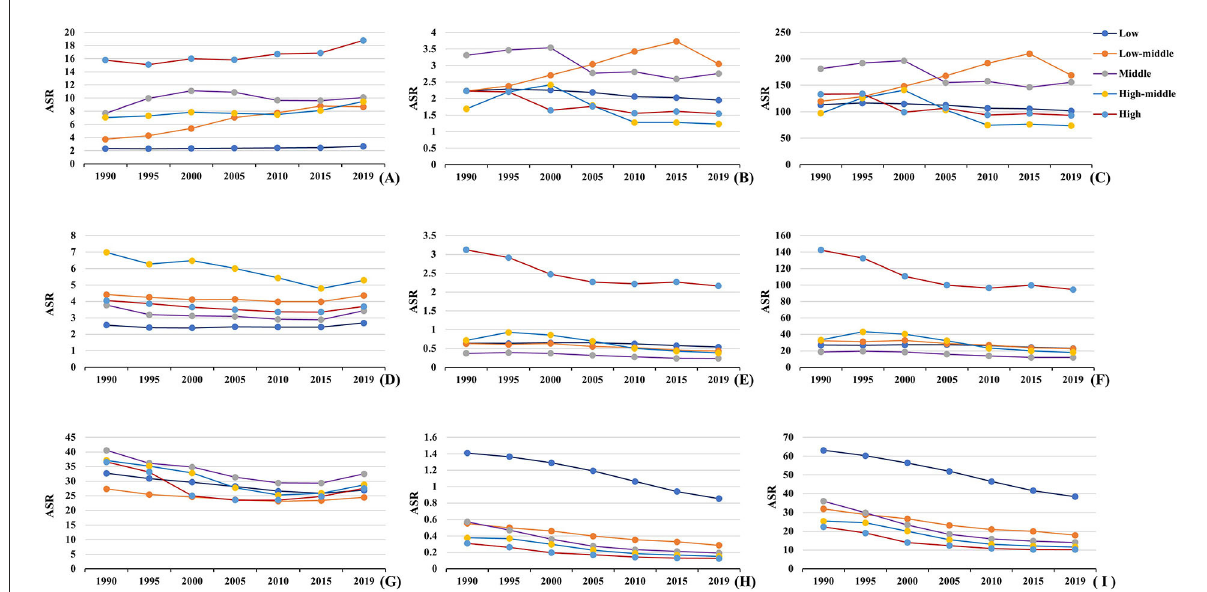
FIGURE3 The changes in the ASRs of FV burden in SDI areas from 1990 to 2019. (A–C) were the ASRs of incidence, death, and DALYs of PVF. (D–F) were the ASRs of death, and DALYs of SHF. (G–I) were the ASRs of incidence, death, and DALYs of UFI, respectively. PVF, physical violence; SHF,